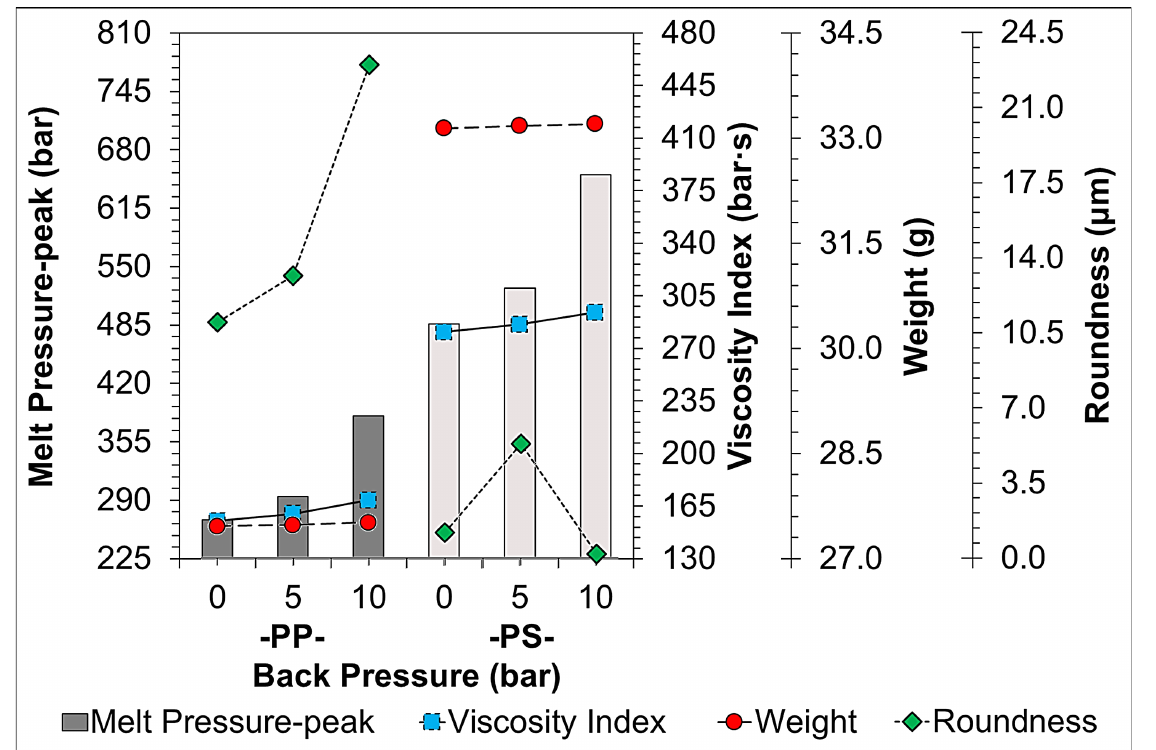
Figure 12. Trend-diagram of the effect of back pressure on melt pressure-peak (bar-graph), calculated viscosity index (continuous-line), and its sample weight (chain-line)/roundness (dotted-line).